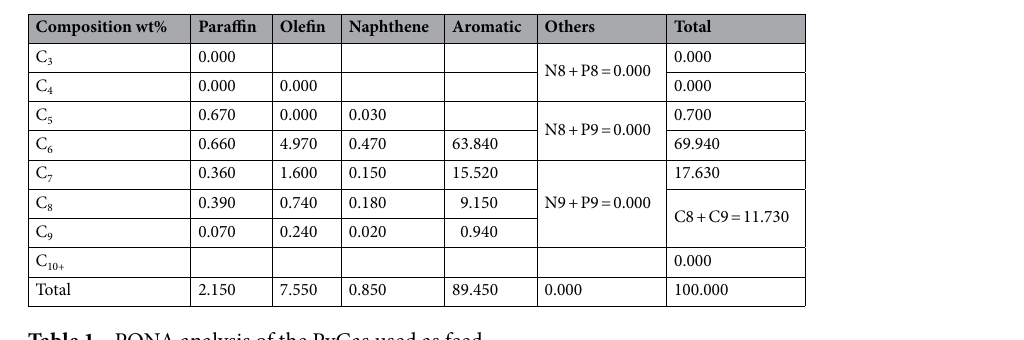
Table 1. PONA analysis of the PyGas used as